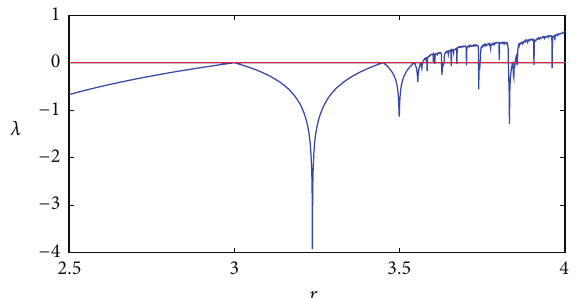
Figure 3: Logistic map Lyapunov